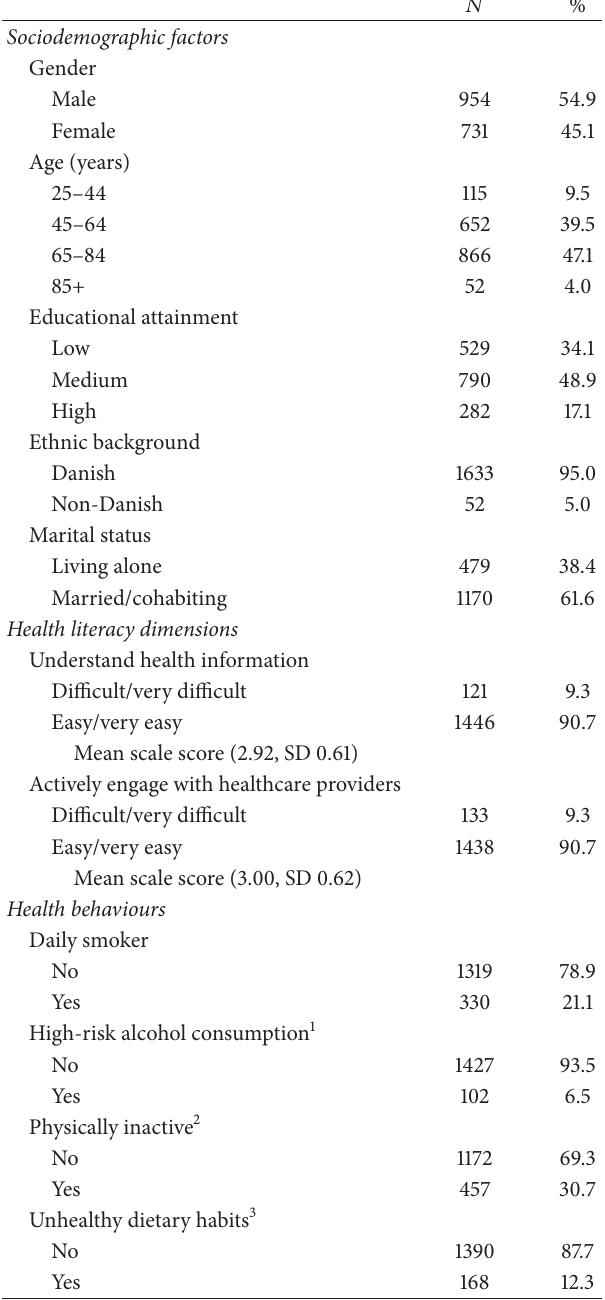
Table 1: Characteristics of participants with diabetes from the “How Are You?” survey, Central Denmark Region (2013) ( 𝑁 = 1